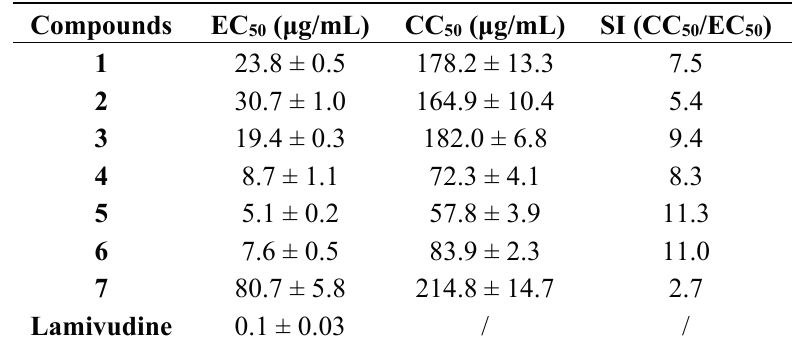
Table 2. Anti-HBV activity of 1 – 7